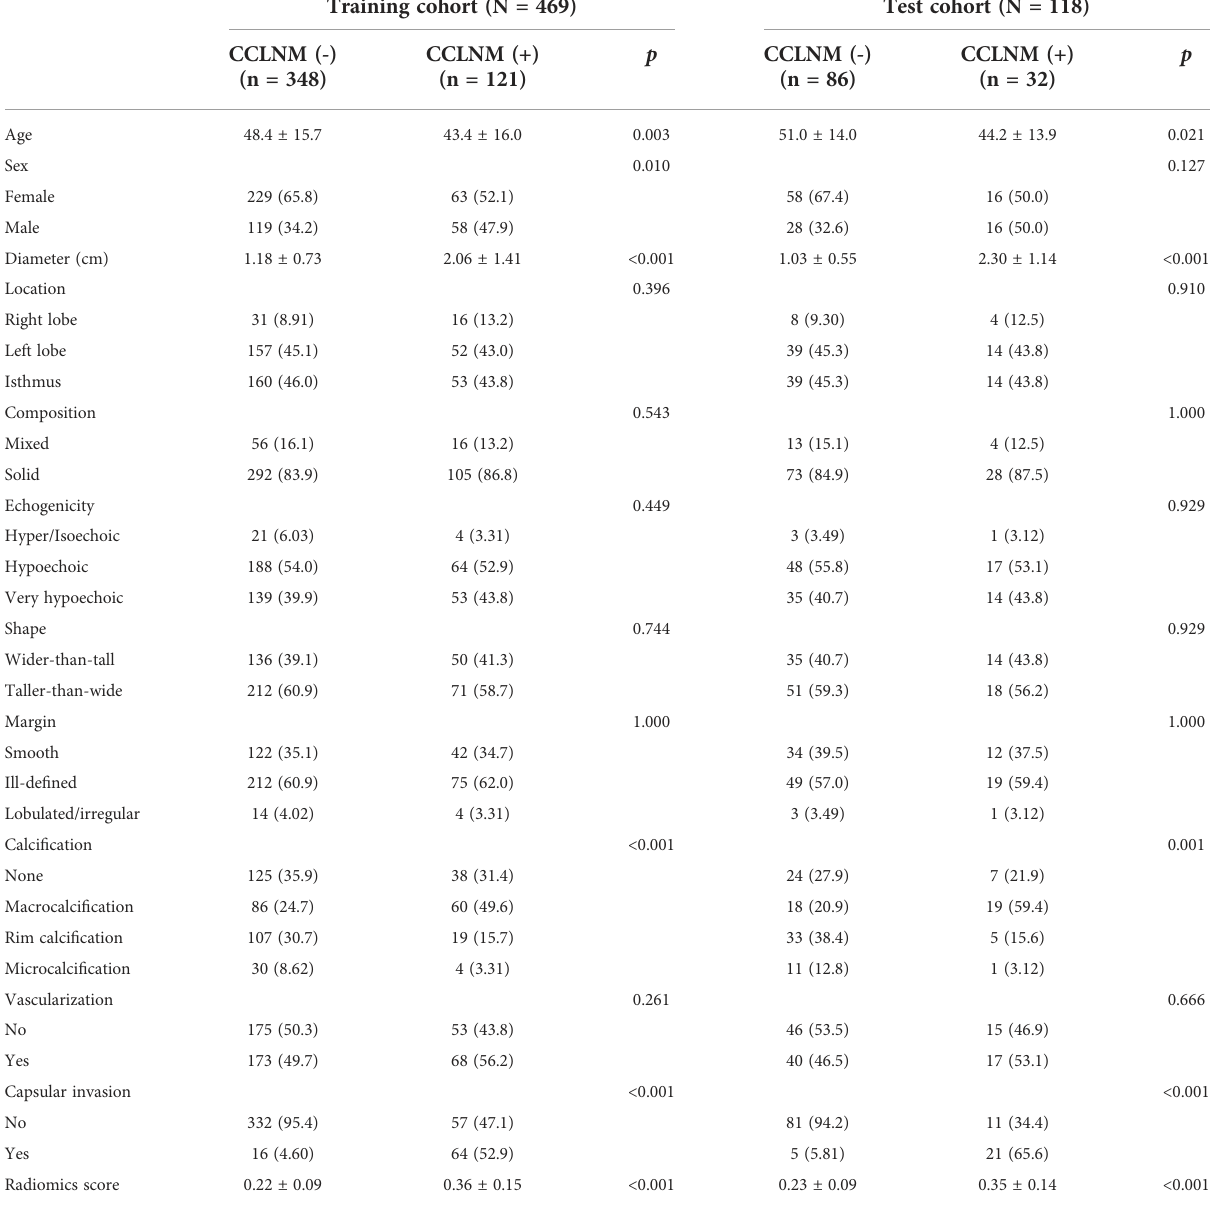
TABLE 1 Demographics and ultrasound image characteristics in the training and test